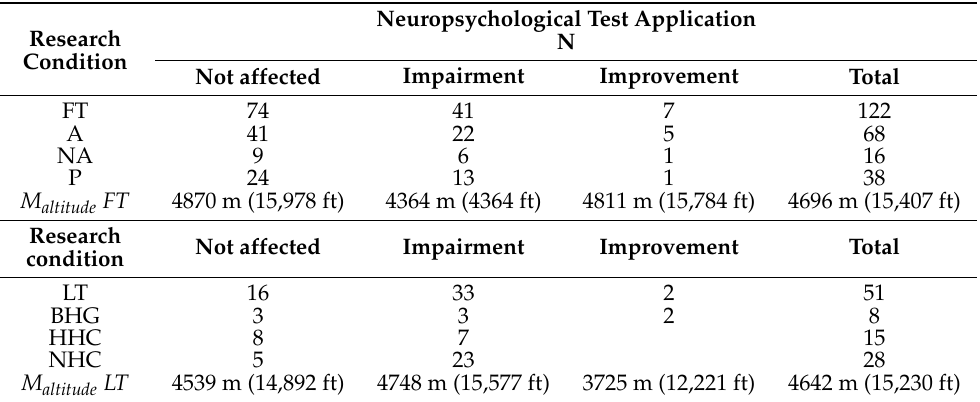
Table 3. Frequency of neuropsychological test results depending on research